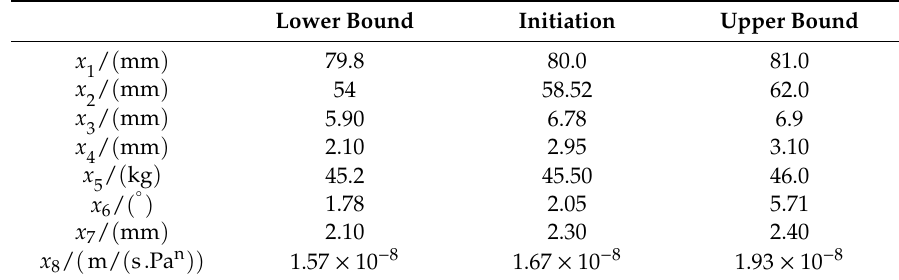
Table 5. The nominal values and the searching ranges of the design variables. Lower Bound